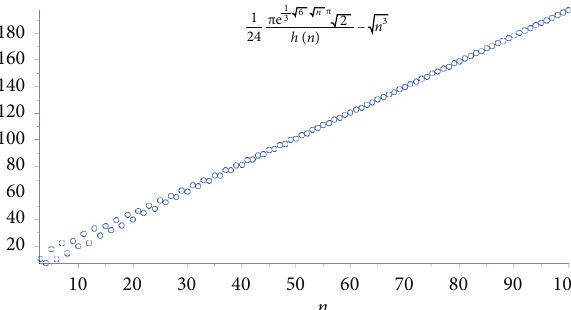
Figure 25: The graph of the data ( n,C